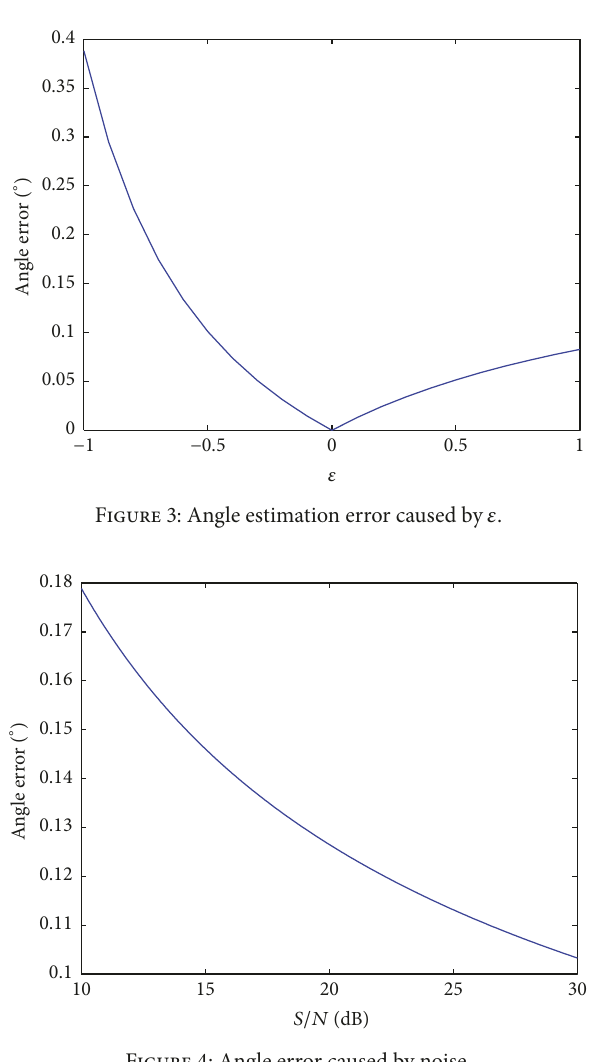
Figure 4: Angle error caused by noise.